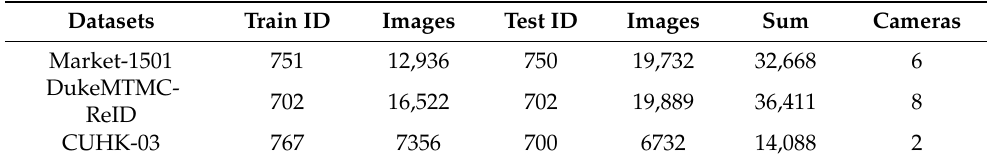
Table 2. The specific introduction of the